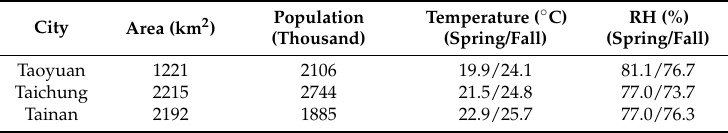
Table 2. Summary of city area, population, climatological temperature, and relative humidity (RH) in Taoyuan, Taichung, and Tainan. The area and population data were obtained from the Ministry